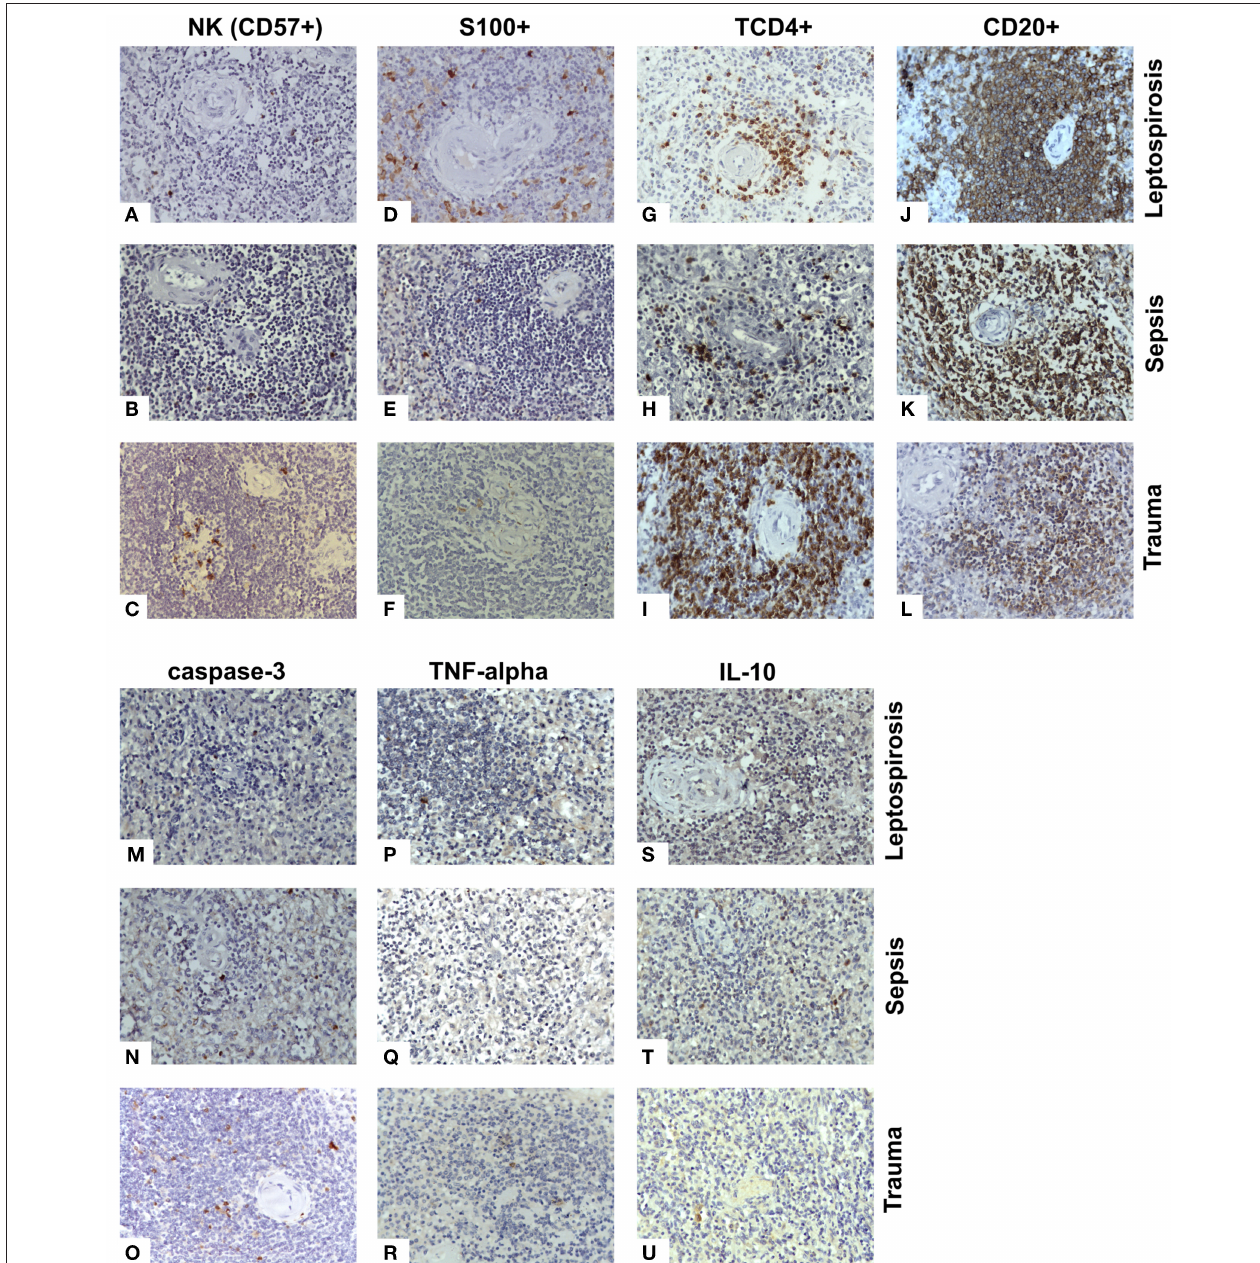
FIGURE 2 | Antigen expression for cell receptors, cytokines and apoptosis in the white pulp of the spleens from fatal cases of Leptospirosis with pulmonary hemorrhage and shock. (A–C) NK cells (CD57 + ) were present at lower levels in the leptospirosis and sepsis groups as compared to the control group. (D–F) The S100 cells were higher in the leptospirosis group than the sepsis and control groups. (G–I) The TCD4 + cells were in lower quantity in the leptospirosis and sepsis groups than in the control group. (J–L) Both leptospirosis and sepsis groups had more CD20 + cells than patients with control in the white pulp. (M–O) Cleaved caspase 3 positive (apoptotic) cell levels were lower in the leptospirosis and sepsis groups than in the control group in the white pulp. (P–R) TNF- α levels were higher in the leptospirosis group as compared to sepsis and control in both the white and red pulps. (S–U) The number of cells expressing IL-10 was greater in leptospirosis and sepsis groups as compared to control in both red and white pulps. Magnification: 400 ×